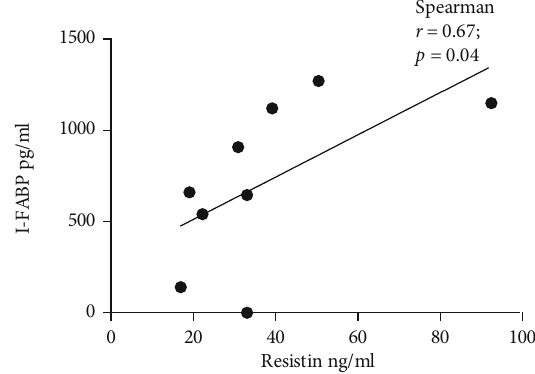
Figure 4: Correlation between I-FABP and resistin level in the GDM group. The data for resistin level were available in 9 GDM